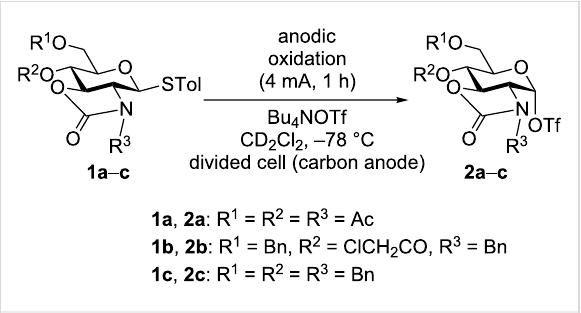
Scheme 1: Electrochemical conversion of thioglycosides to glycosyl triflates.